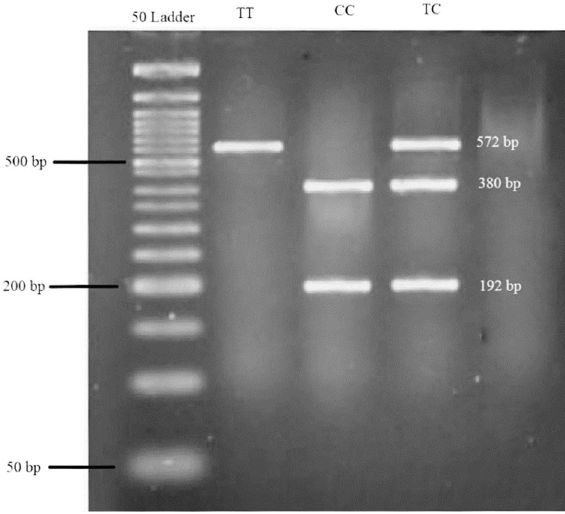
Figure 3. Electrophoretic gels and blots for FADS2